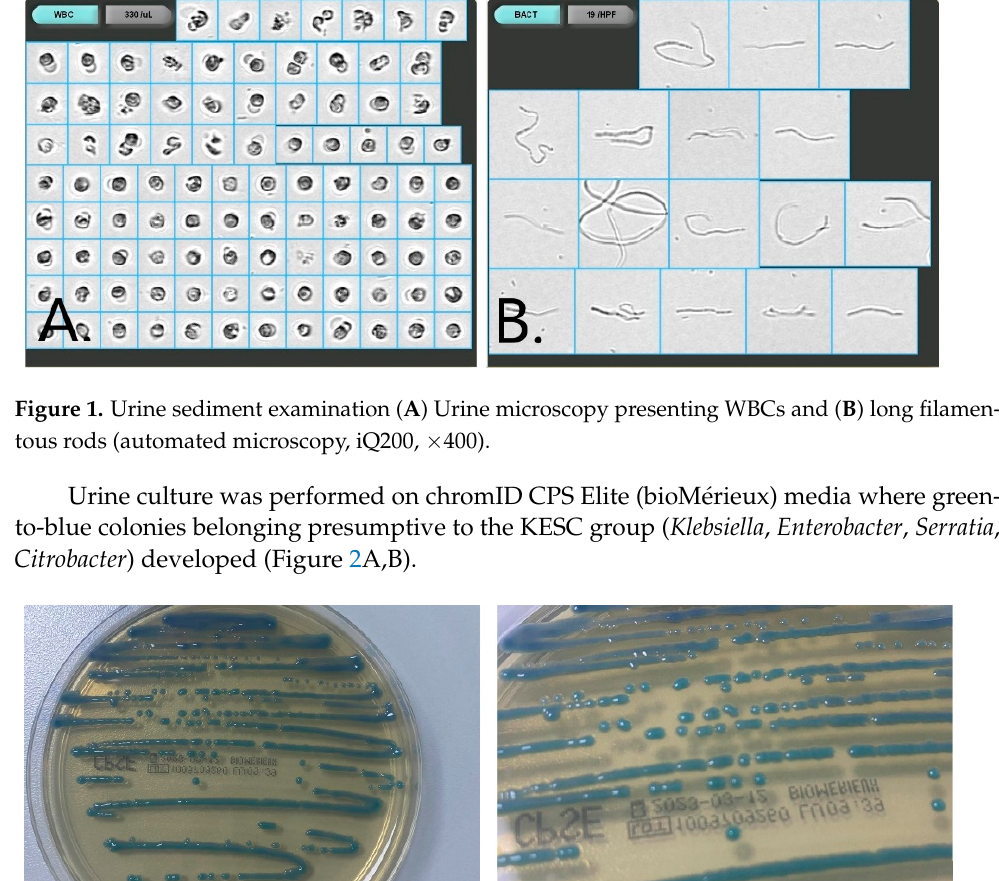
Figure 3. ( A , B ) Gram stain of the pure isolated bacterial colonies presenting long filamentous Gram- negative rods (x1000). The Gram-negative rod was identified to be Raoultella planticola using VITEK ® 2 sys- temand then confirmed via MALDI–TOF (matrix-assisted laser desorption ionization– time-of-flight). Further antibacterial susceptibility was commenced on VITEK ® 2 system and revealed sensibility to Amoxicillin/Clavulanic Acid, Piperacillin/Tazobactam, Cefo- taxime, Ceftazidime, Cefepim, Ertapemen, Imipenem, Meropenem, Amikacin, Gentami- cin, Ciproprofloxacin, Nitrofurantoin, Trimethoprime + sulfamethoxazole and resistance to Ampicillin (Table 1). Table 1. Susceptibility results obtained in vitro on VITEK ® 2 system for Raoultella planticola (isolated pure culture obtained from urine, US pump and isotonic solution). Antibacterial